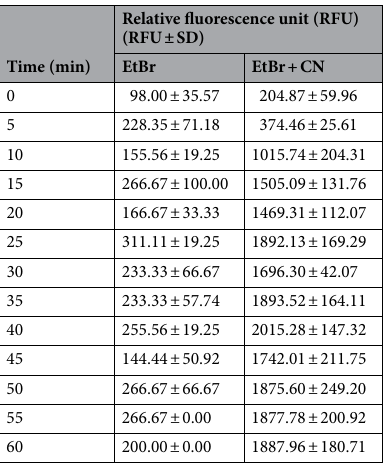
Table 1. Fluorescent readings of influx assay conducted on KPC-KP cells.